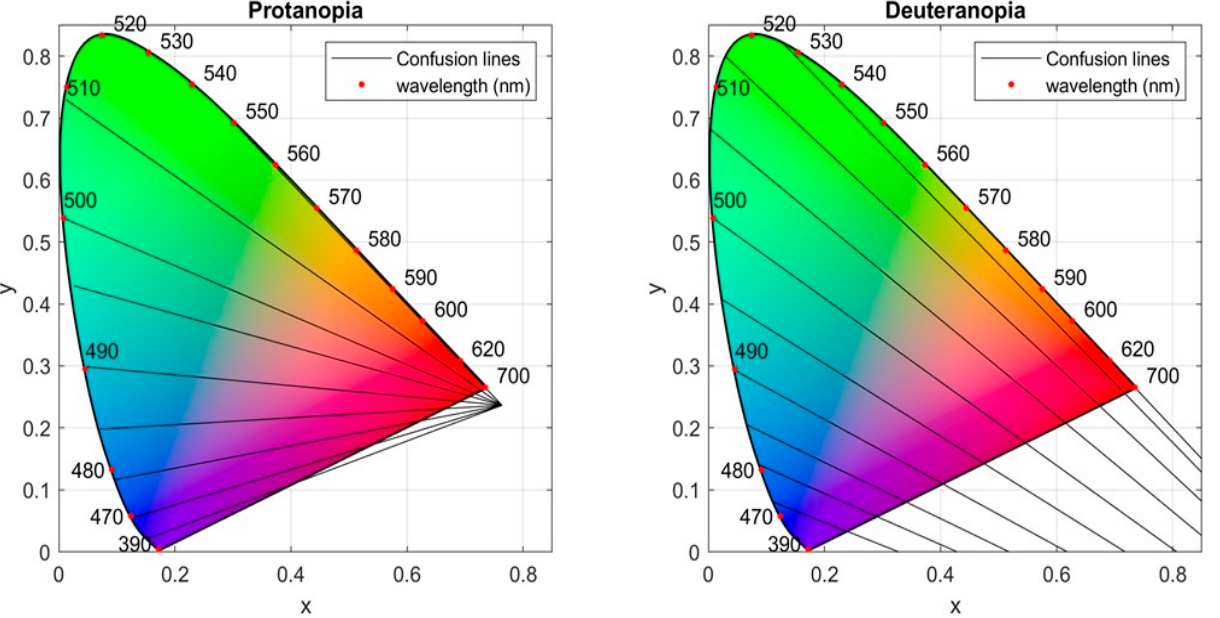
Figure 1. Confusion lines for protanopia ( left diagram ) with copunctal point ( x cp , y cp ) = ( 0.763, 0.236 ) and deuteranopia ( right diagram ) with copunctal point ( x cp , y cp ) = ( 1.4, − 0.4 )